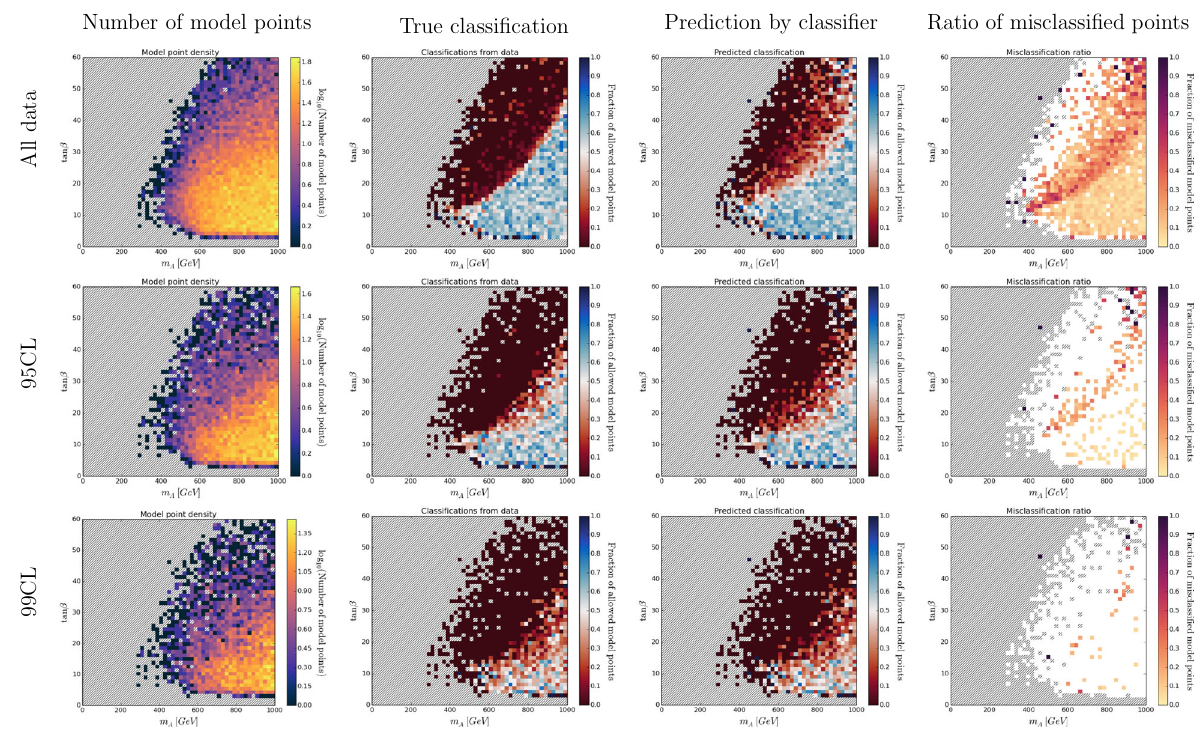
Fig. 17 Color histograms for a projection of the 19-dimensional pMSSM parameter space on the m A 0 –tan β plane. The color in the second and third column indicates the fraction of allowed data points